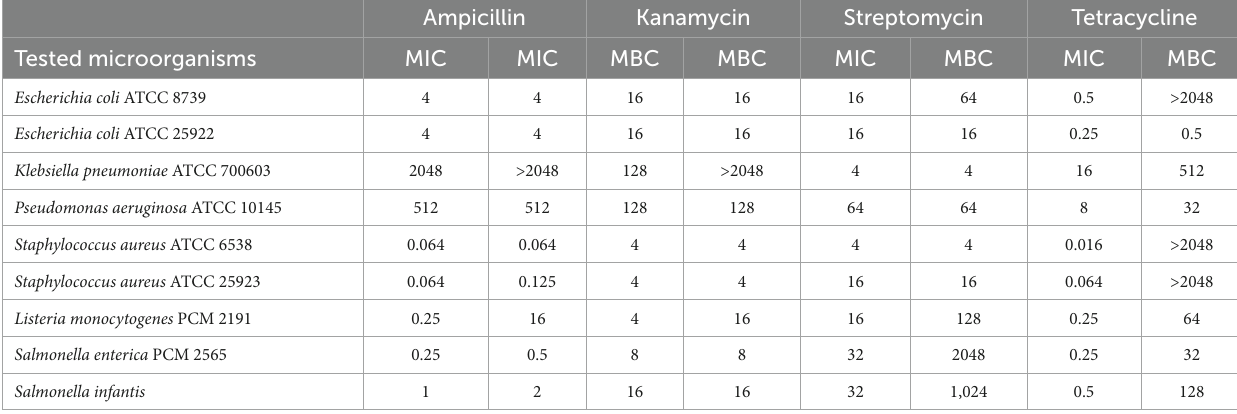
TABLE 2 MIC and MBC values [ μ g mL − 1 ] of antibiotics: streptomycin, kanamycin, ampicillin, and tetracycline against human pathogenic bacteria. Ampicillin Kanamycin